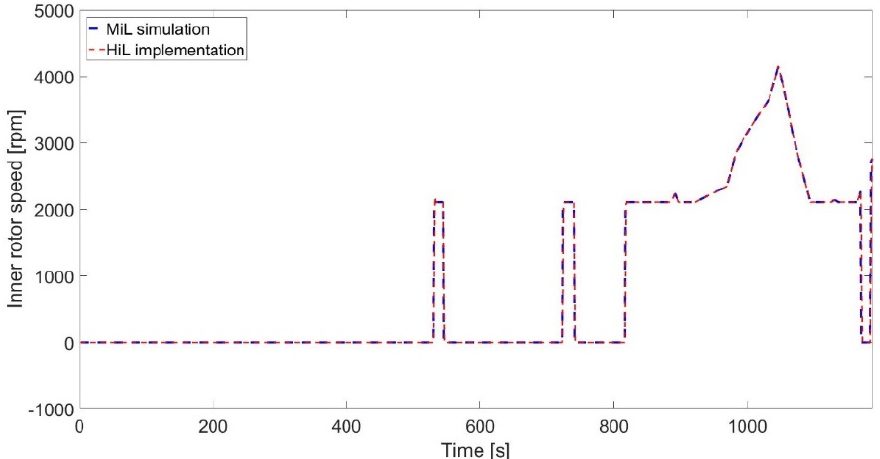
Figure 17. HiL (experimental) vs. MiL agreement results for the inner rotor speed, LPF-based EMS.